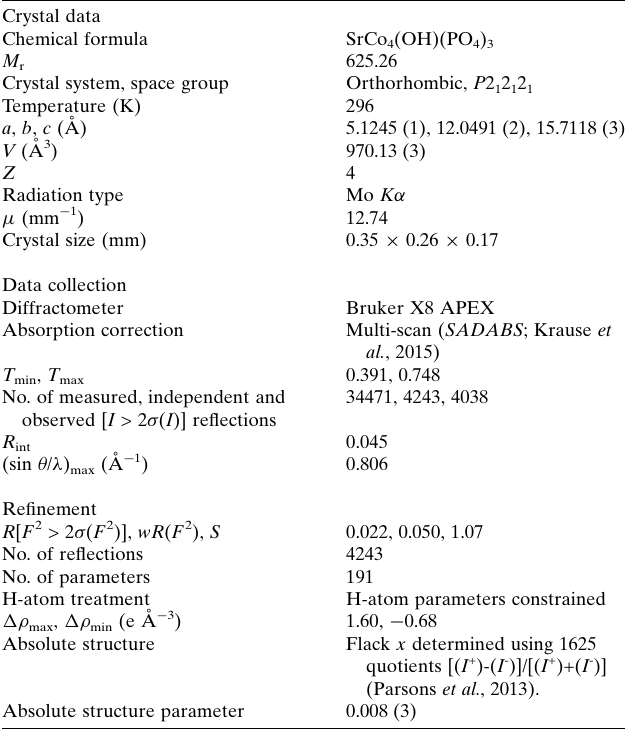
Table 3 Experimental